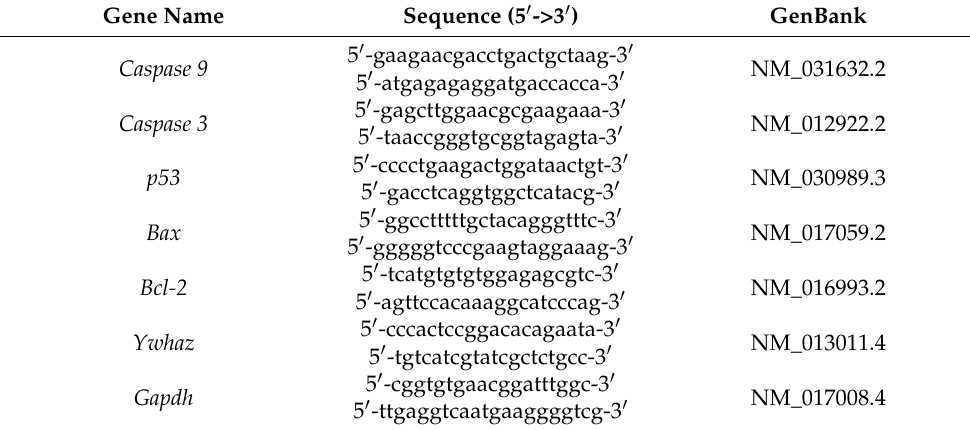
Table 1. Primer sequences for RT-PCR analysis.